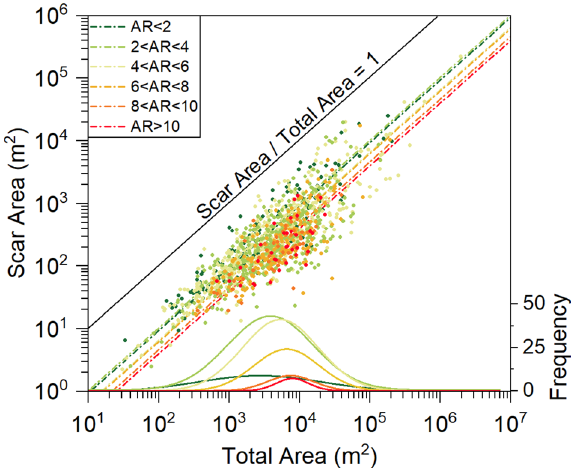
Figure 2. Scatterplot showing the relationship between the scar area and the total landslide area as obtained for a subsample of 1500 landslides from the inventory (Fig. 1). The points are coloured according to the aspect ratio (AR). The linear fitting functions (Table 2) and the landslides size frequency distribution for each AR class are also